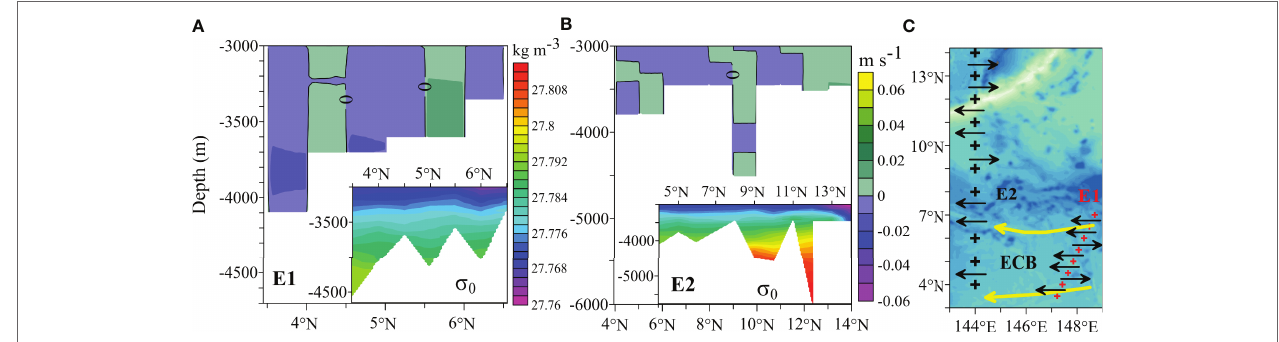
FIGURE 6 | Zonal geostrophic flows at sections E1 (A) and E2 (B) in the East Caroline Basin, and flow pattern along the sections (C) . Potential density σ 0 are also presented.